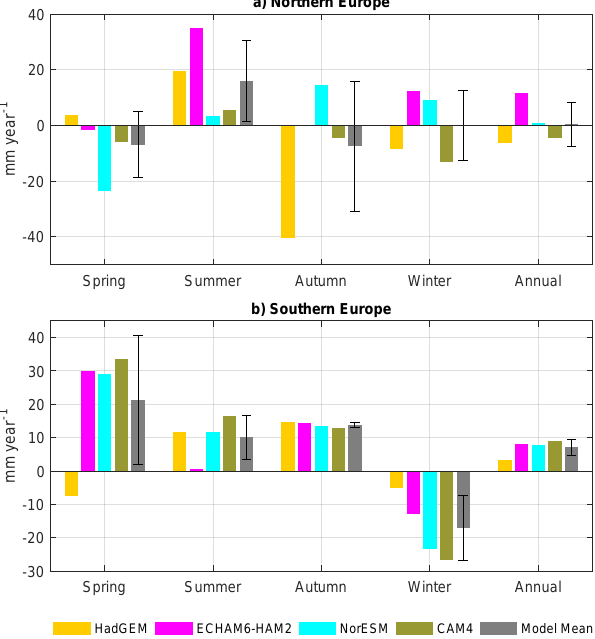
Figure 17. Seasonal and annual mean differences in precipitation (in mmyr − 1 ) over northern (a) and southern (b) Europe between transient simulations of the mitigation (MIT) scenario and the cur- rent legislation (CLE) scenario, averaged over the last 10 years of the simulations (2041–2050). Regions are defined as in Fig. 15a, b. Results are shown for the four ECLIPSE models individually and for the multi-model mean. Positive values mean that MIT simula- tions have more precipitation than CLE simulations. Error bars on the model-mean values show the standard deviations of the individ- ual model